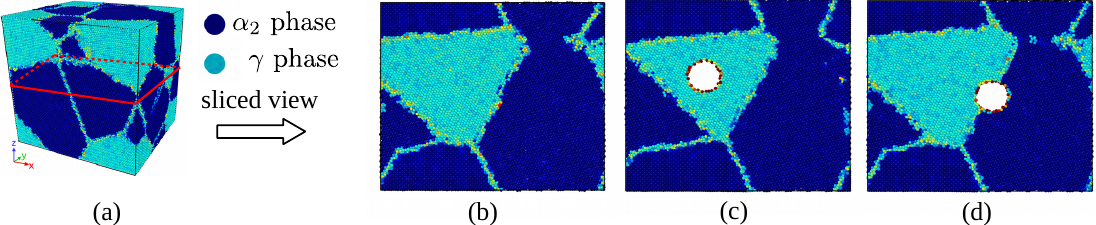
Figure 8. Model of the simulation ( a ) and sliced view of the model with no void ( b ), inside α 2 phase ( c ) at α 2 / γ phase boundary ( d ).